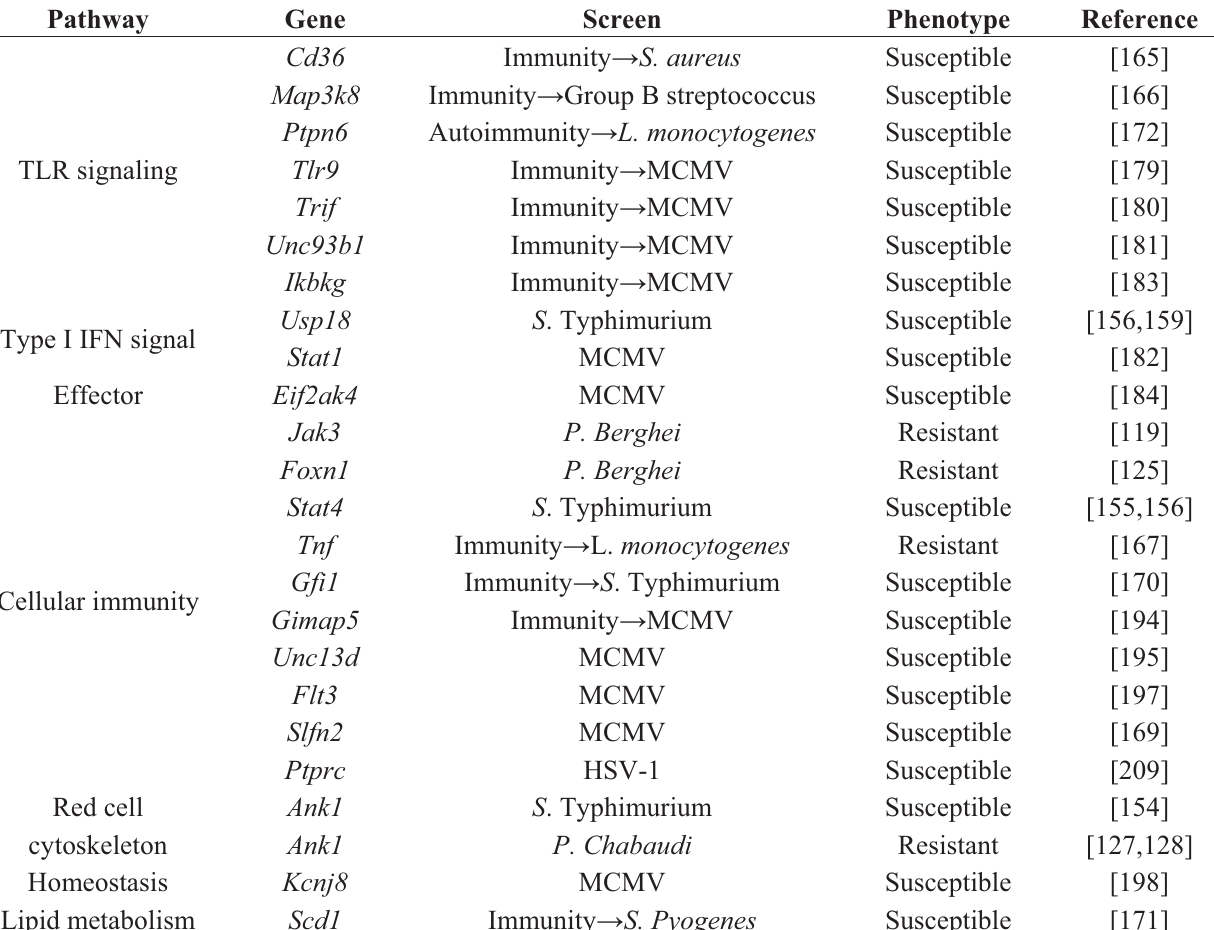
Table 3. Genes and pathways identified in ENU screens described in this review. Pathway